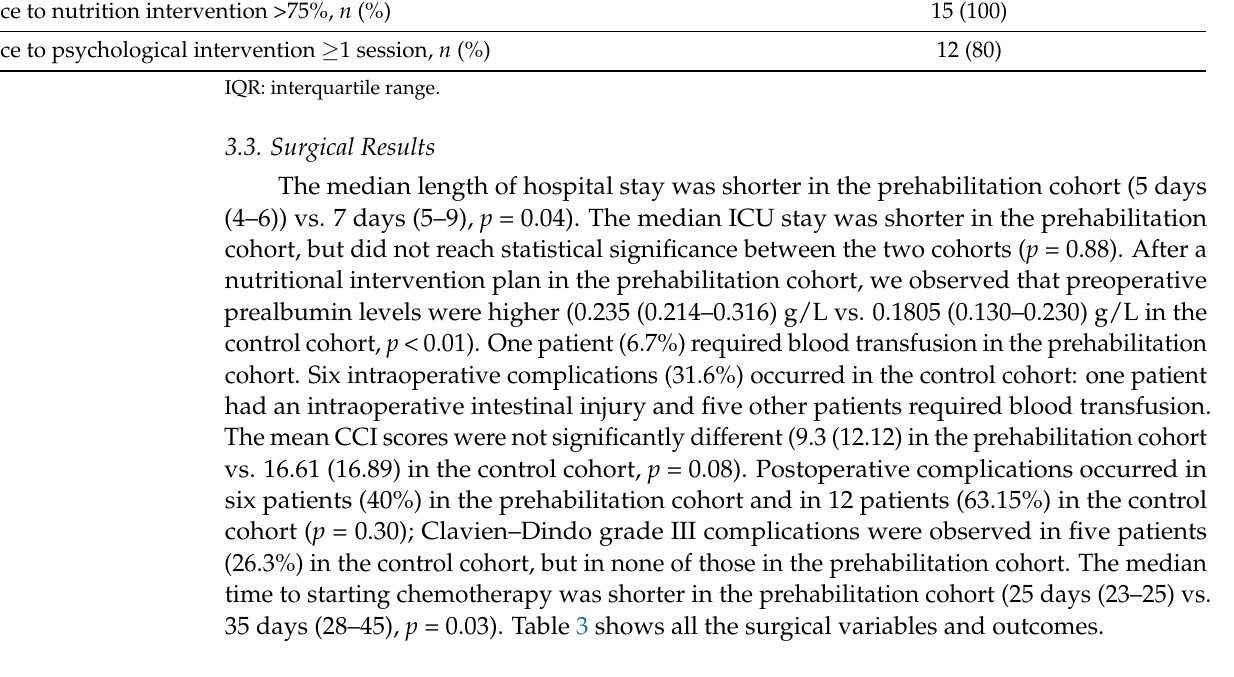
Table 3. Surgical and oncological outcomes of patients with advanced ovarian cancer treated with or without multimodal